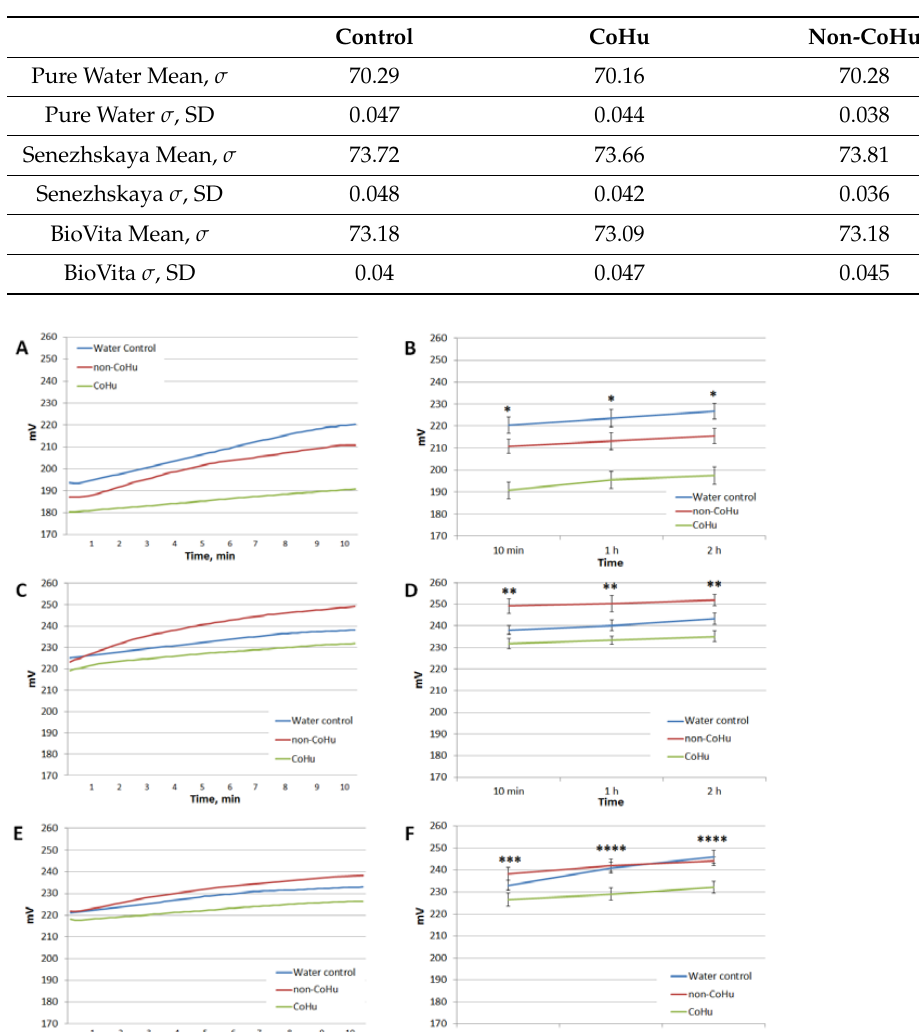
Figure 2. ( A ) A typical continuous measurement of redox potential in pure water in control samples (blue lines), samples Table 1. min after treatment. ( B ) Mean redox potential data recorded 1 and 2 h after treatment are presented. * p < 0.05 between the three groups of samples by paired comparison by Mann–Whitney U-test. ( C ) A typical continuous measurement of redox potential in BioVita. ( D ) Mean redox potential data in BioVita recorded 1 and 2 h after treatment. ** p < 0.05 samples treated with CoHu differ from the two other groups. ( E ) A typical continuous measurement of redox potential in Senezhskaya mineral bottled water. ( F ) Mean redox potential data in